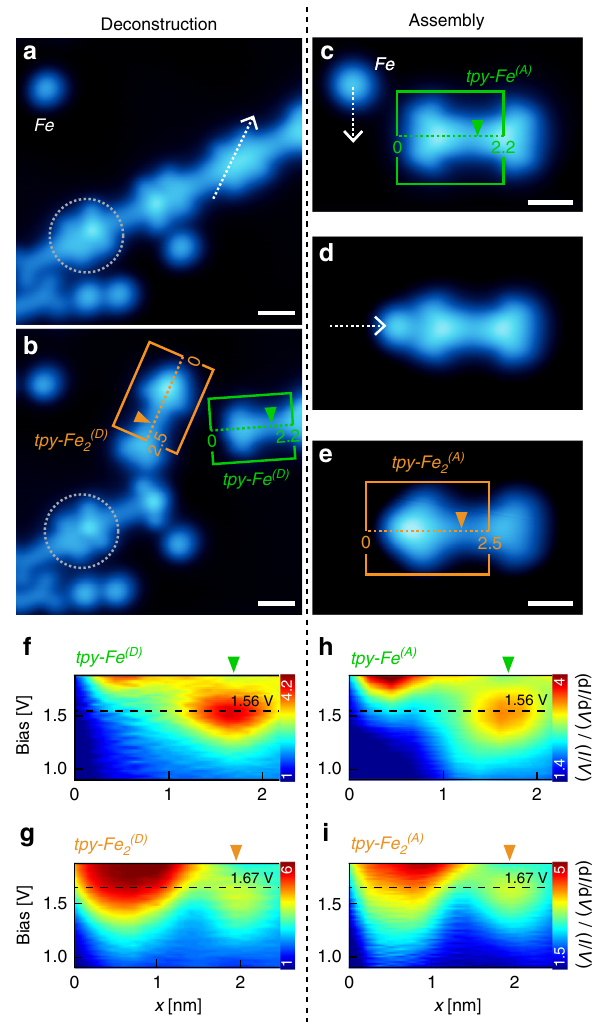
Fig. 3 Direct demonstration of tri-iron coordination node via STM manipulation. a , b STM images ( V b = − 500 mV; a: I t = 50 pA; b: I t = 400 pA) before and after lateral tip movement (white dashed arrow) across coordination node in MOC. The node is composed of two types of metalated tpys : tpy – Fe 2 (D) and tpy – Fe (D) . Grey dashed circle indicates coordination node decorated with a CO molecule (Supplementary Fig.